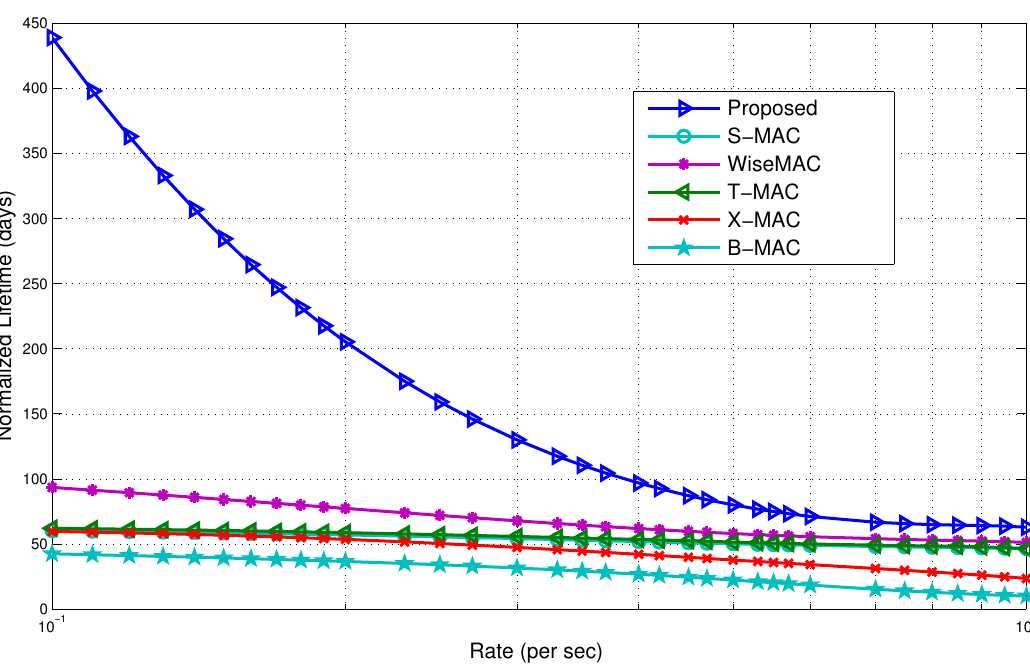
Figure 23. Delay comparison with non-standard protocols.